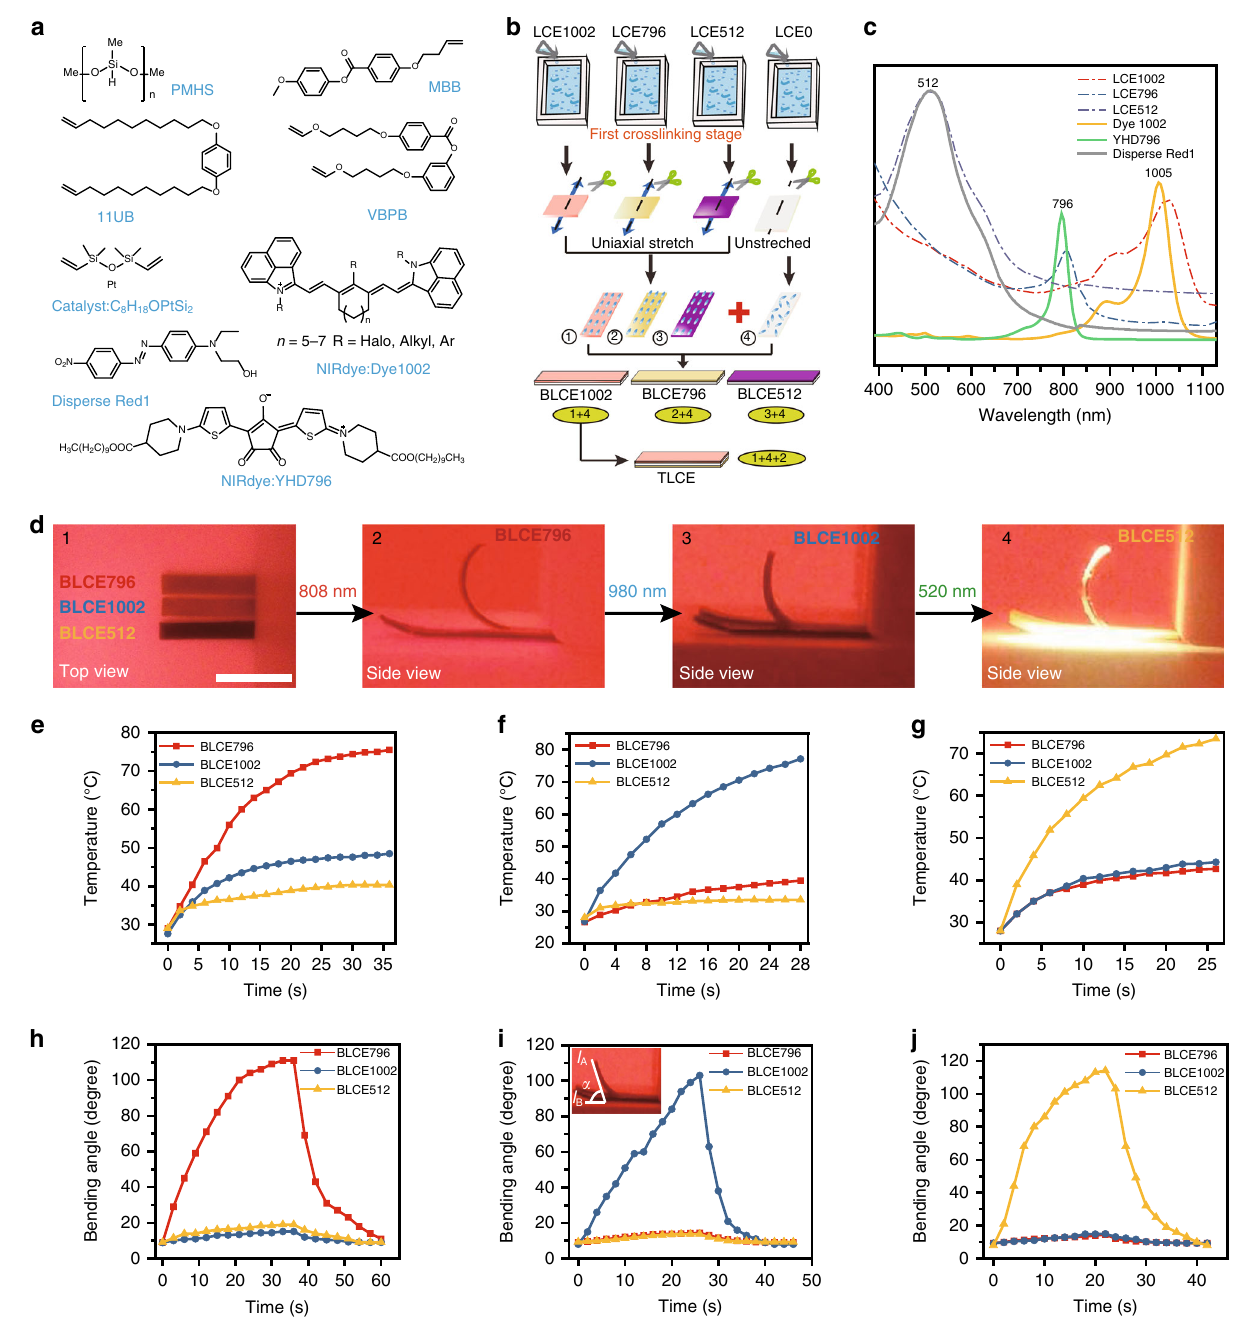
Fig. 1 Design and investigation of NIR wavelength-selective responsive properties of LCE system. a The chemical components used in this LCE system. b Schematic illustration of the preparation procedures of BLCE1002, BLCE796, BLCE512 and TLCE. c UV-Vis-IR absorption spectra of YHD796 (conc. = 1.4 × 10 − 3 mg mL − 1 ), Dye1002 (conc = 1.5 × 10 − 3 mg mL − 1 ) and Disperse Red1 (conc = 5.0 × 10 − 3 mg mL − 1 ) in dichloromethane, and the corresponding LCE796, LCE1002, and LCE512 fi lms. d The photographs of the actuation motions of BLCE796, BLCE1002, and BLCE512 fi lms with one end fi xed, under the stimulation of 808 nm, 980 nm, and 520 nm light respectively (scale bar = 0.5 cm). Temperature pro fi les of BLCE796, BLCE1002, and BLCE512 fi lms irradiated by ( e ) 808 nm, ( f ) 980 nm, and ( g ) 520 nm light. The diagrams of the included angle α of BLCE796, BLCE1002, and BLCE512 plotted against the illumination time of ( h ) 808 nm, ( i ) 980 nm, and ( j ) 520 nm light. Source data are provided as a Source Data fi